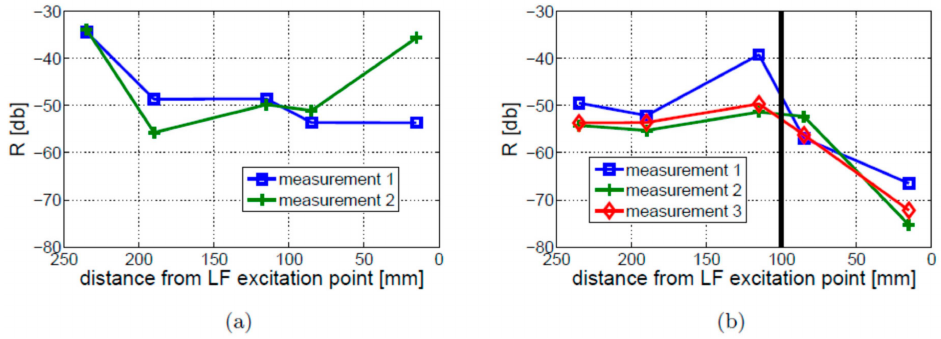
Figure 19. Experimental Test 1—repeatability test for the R coefficient: ( a ) intact beam; ( b ) cracked beam. The crack position is indicated by the vertical solid black line.